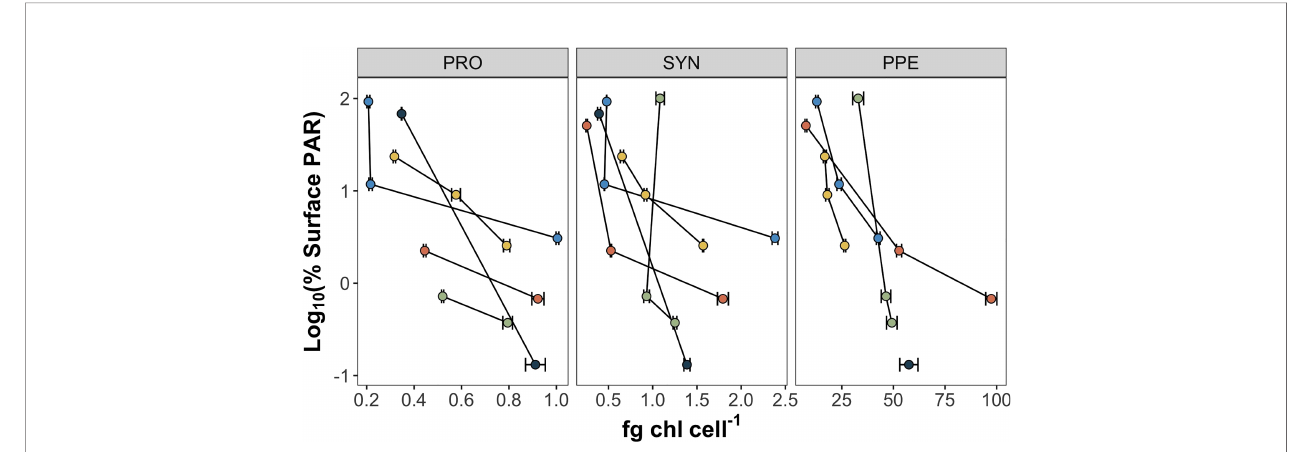
FIGURE 3 | Per-cell Chl a (fg Chl a cell -1 ) for Prochlorococcus (PRO), Synechococcus (SYN), and picophytoeukaryotes (PPE) plotted against log 10 transformed % I 0 . Color markers correspond to different sampling sites. Error bars represent standard error of regression slopes between fi lter Chl a content and the number of cells sorted.